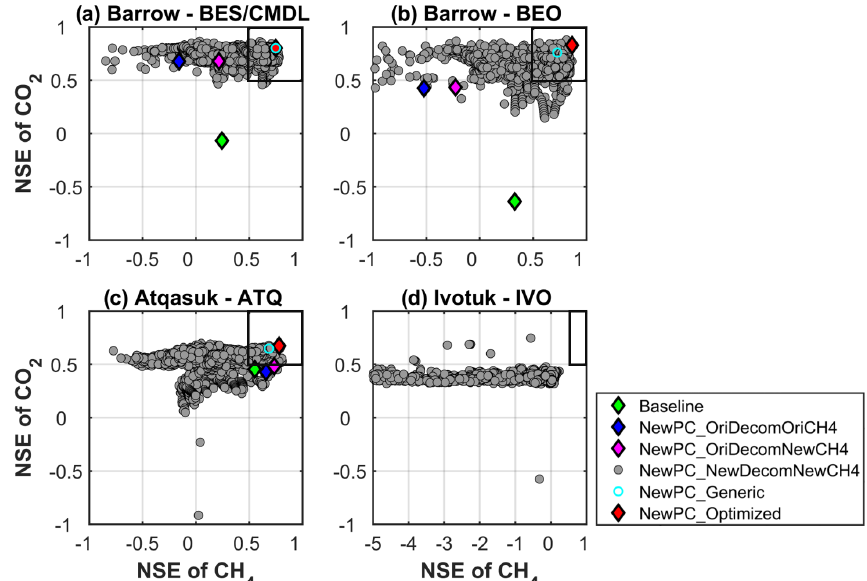
Figure 5. Scatter plot between the Nash–Sutcliffe efficiency (NSE) of simulated monthly CH 4 and CO 2 emissions. An ideal simulation has both NSEs of CH 4 and CO 2 as one (i.e., the upper right corner). The boxes encompass simulations with satisfactory performance (NSE > 0 . 5). Optimized (red) – the best simulation for each site; generic (cyan) – the simulation with a common parameterization of carbon decomposition scheme and CH 4 parameter scheme that provides best overall performance for all the sites. See Table 2 for the configuration for each experiment. The gray dots represent all the tested (1934) simulations indicated in the annotation of Table 2. Symbols outside the plotting ranges indicate poor performance, e.g., ( − 34.9, − 0.3) for baseline at IVO, and thus are not shown in the figure.